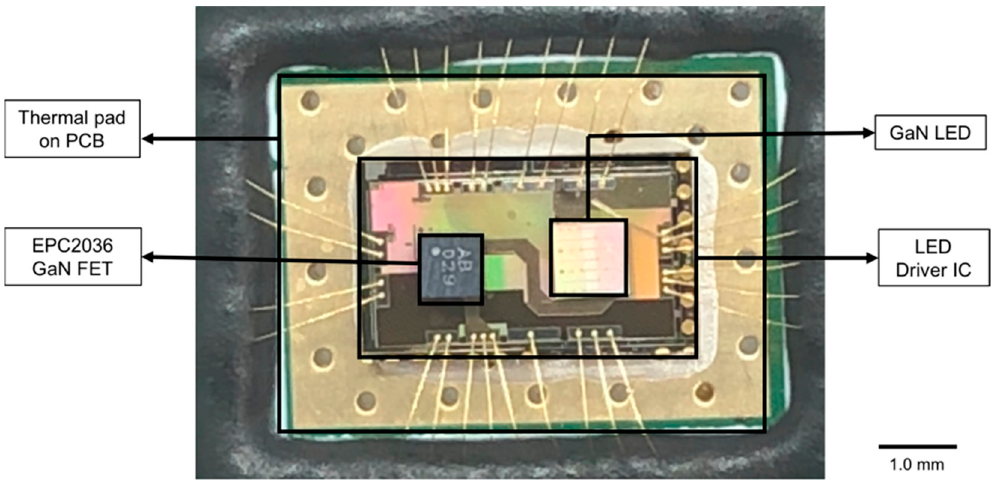
Figure 12. LED driver integrated circuit (IC) wire-bonded to the printed circuit board (PCB) evaluation board.